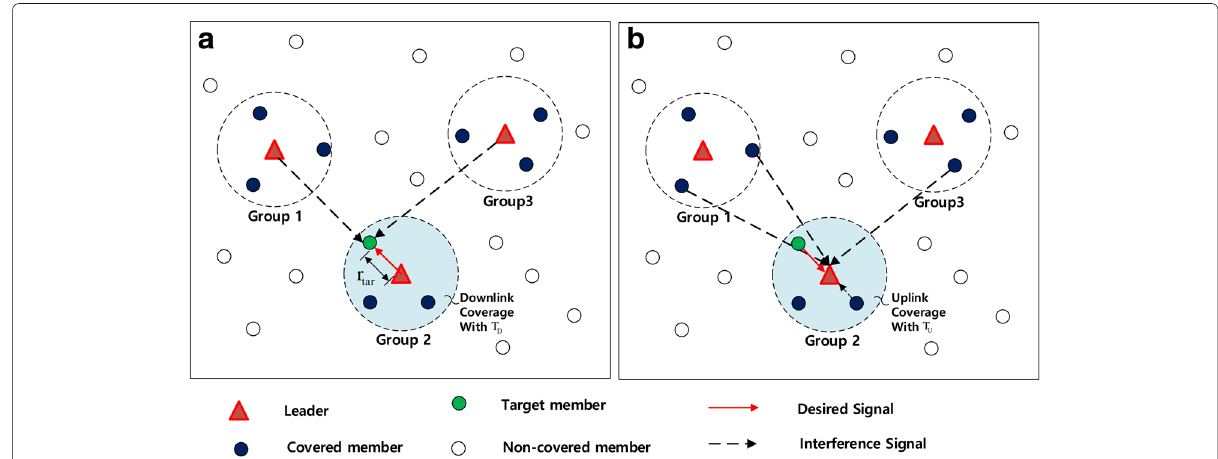
Fig. 1 An example of group communications in a group communication network. a DL transmission. b UL